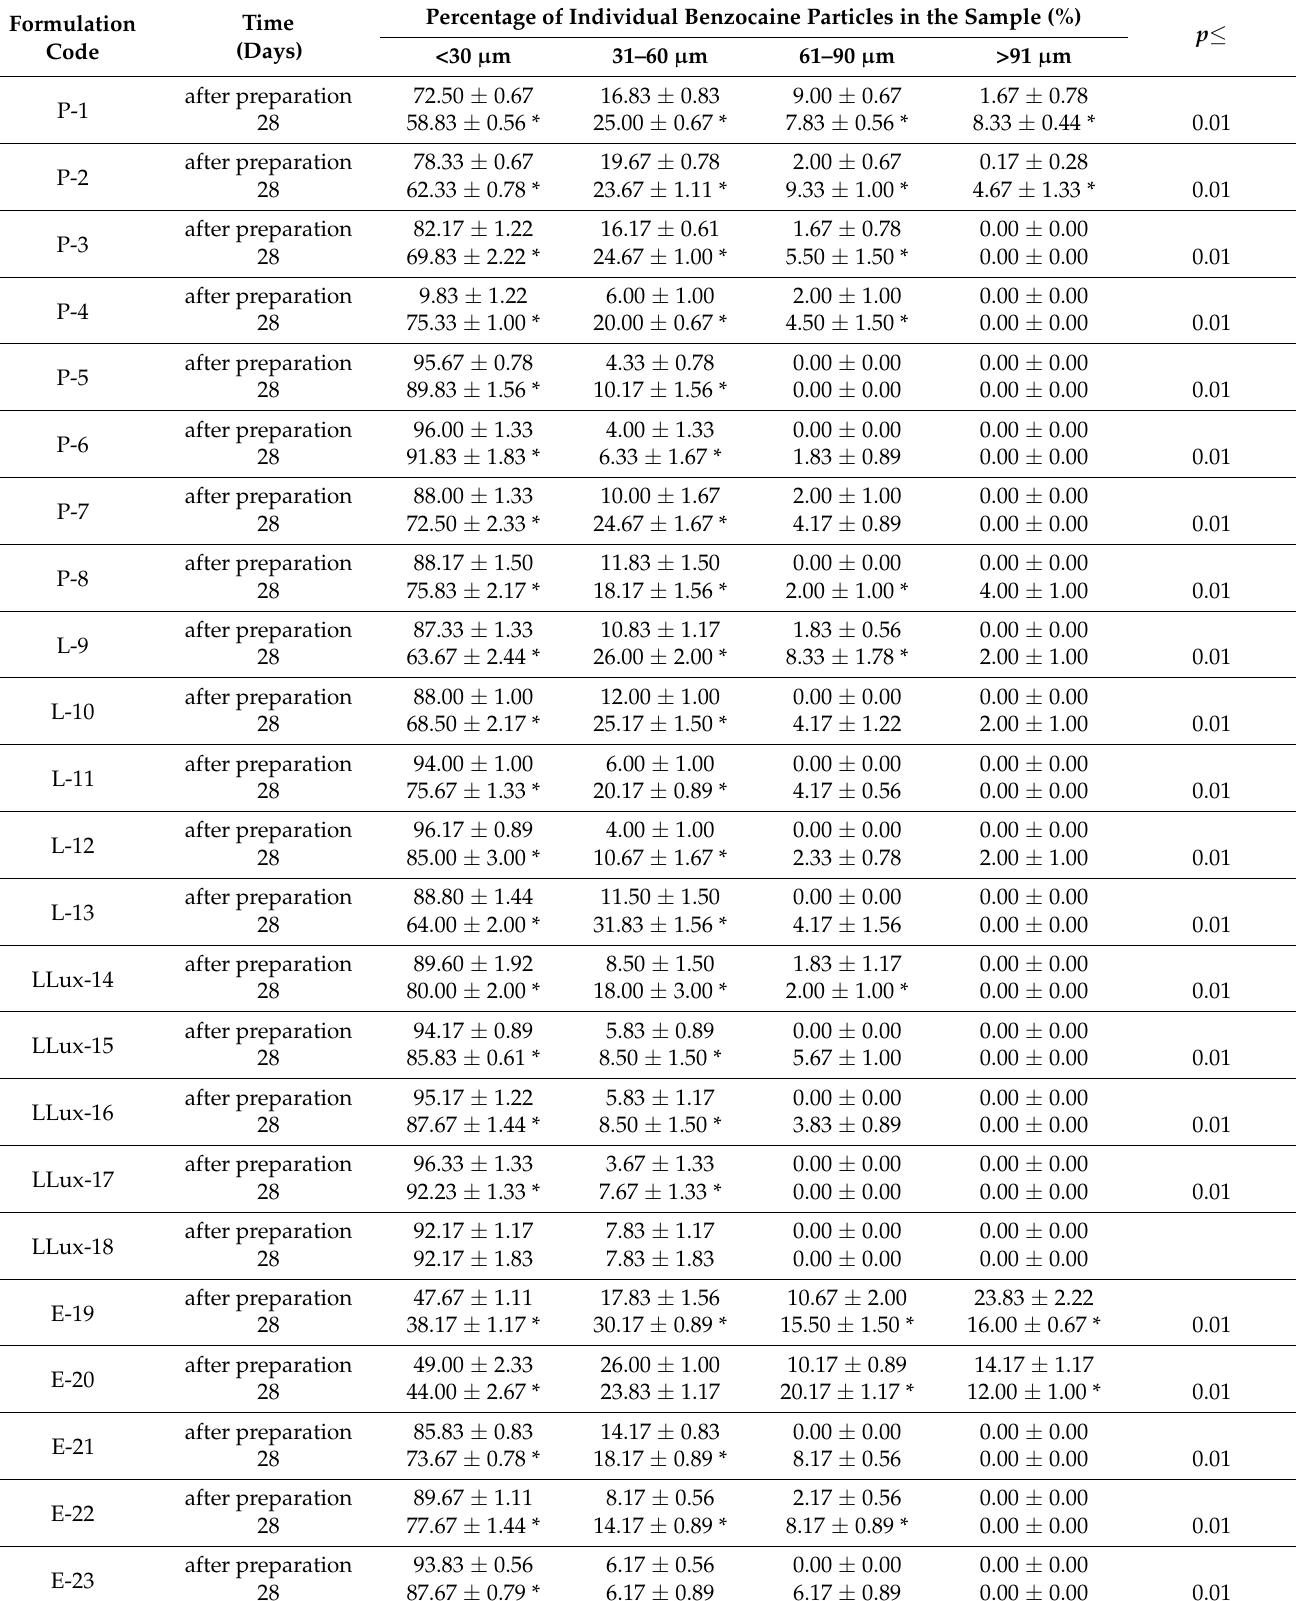
Table 3. Change in benzocaine particle size in suspension-type ointments depending on the used base and storage